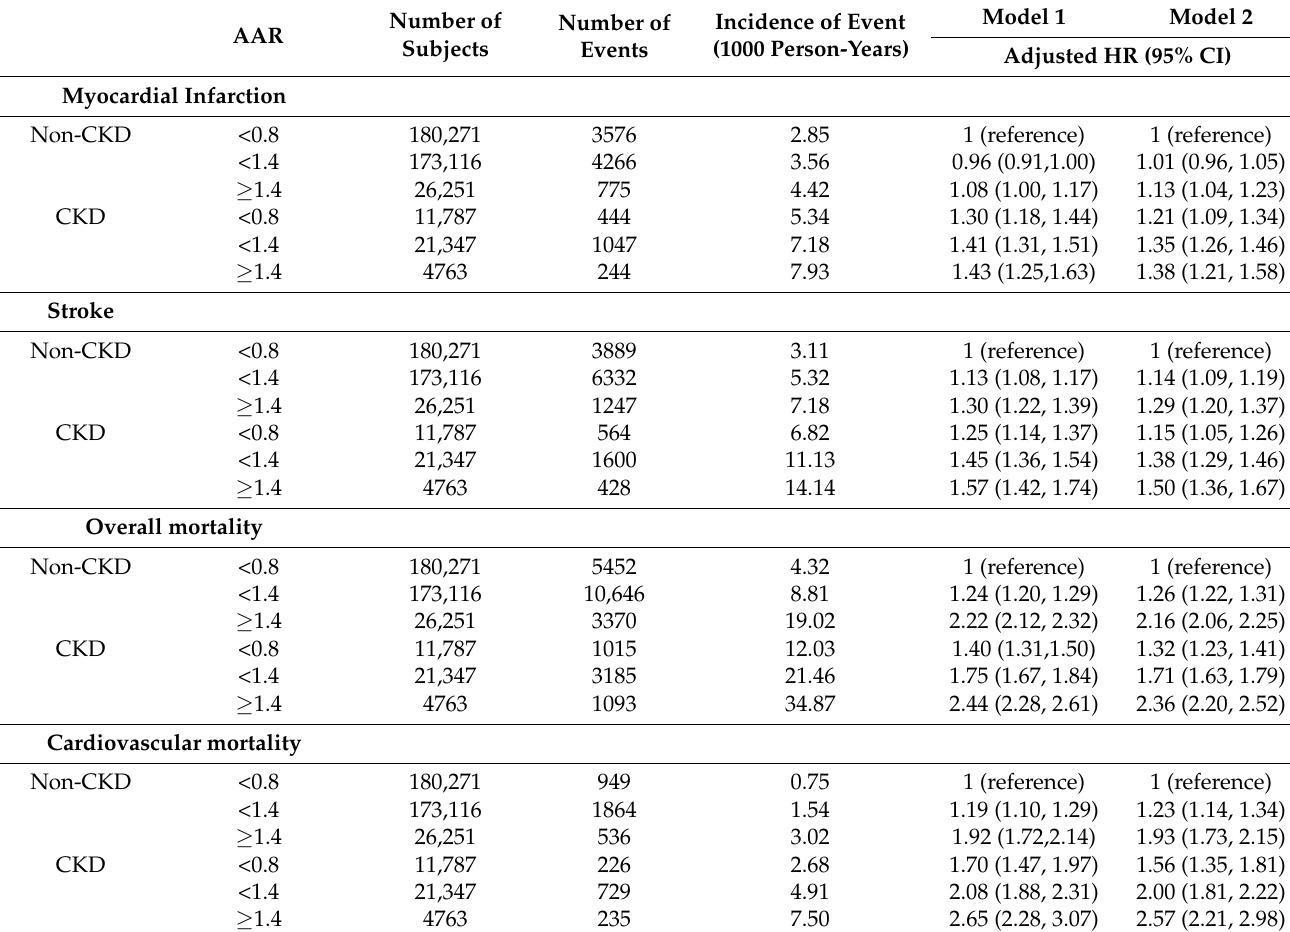
Table 3. Risk of cardiovascular events in subjects with